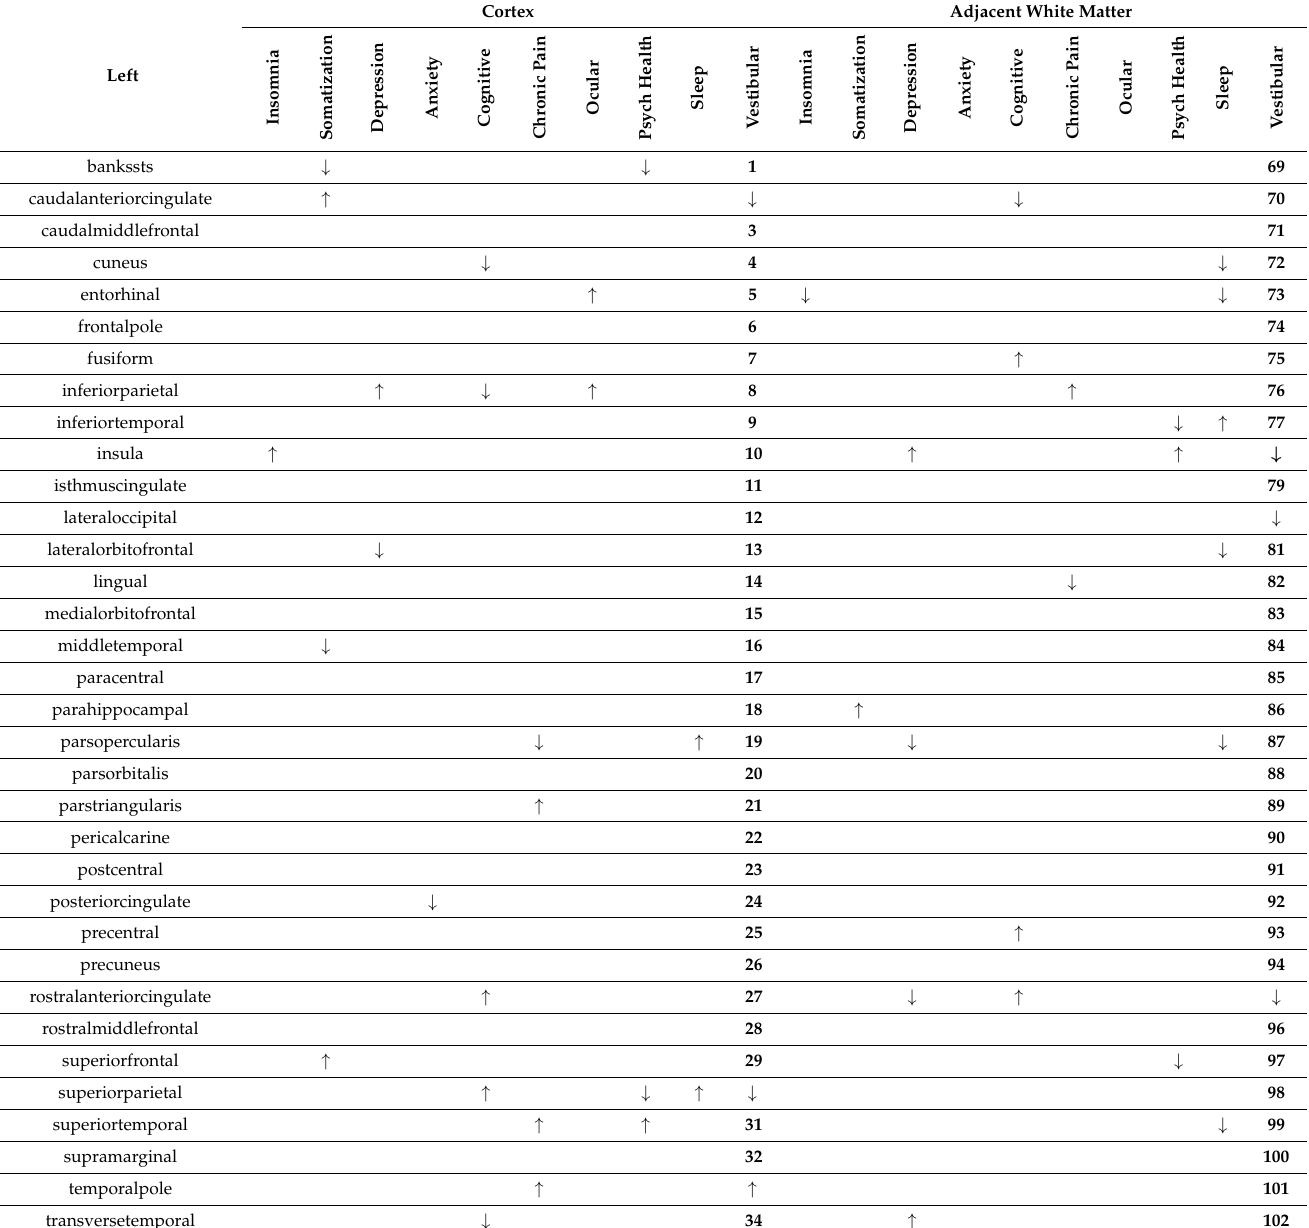
Table 3. The left-side regions whose neuroelectric activity values contributed to the symptom-specific classifiers reported in Table 2 are shown. Activity in regions marked “ ↑ ” was higher in those who screened positive; those marked “ ↓ “ were